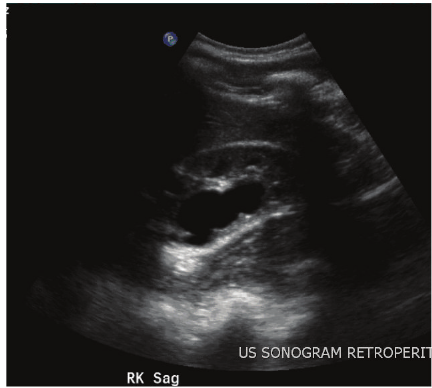
Figure 1: Ultrasound of right kidney read as pelviectasis and possible renal cysts.